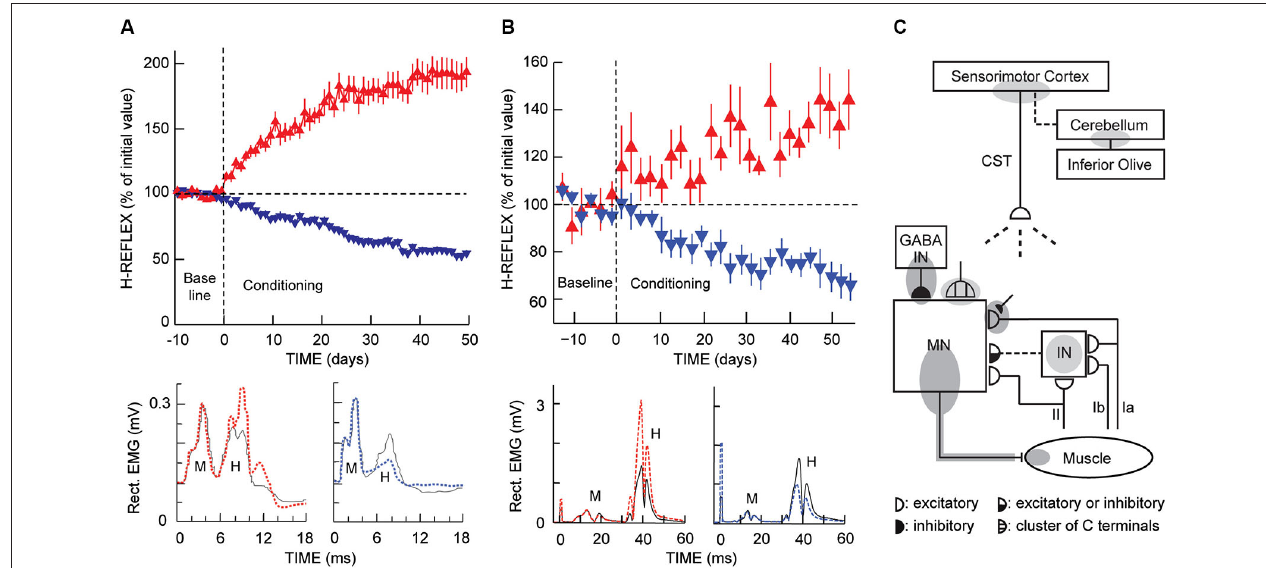
FIGURE 2 | H-reflex operant conditioning results in rats (A) and humans (B), and the hierarchy of brain and spinal cord plasticity that underlies H-reflex conditioning (C). (A) As illustrated in Figure 1 (“Rat H-reflex”), in a rat with chronically implanted EMG electrodes and a tibial nerve cuff,